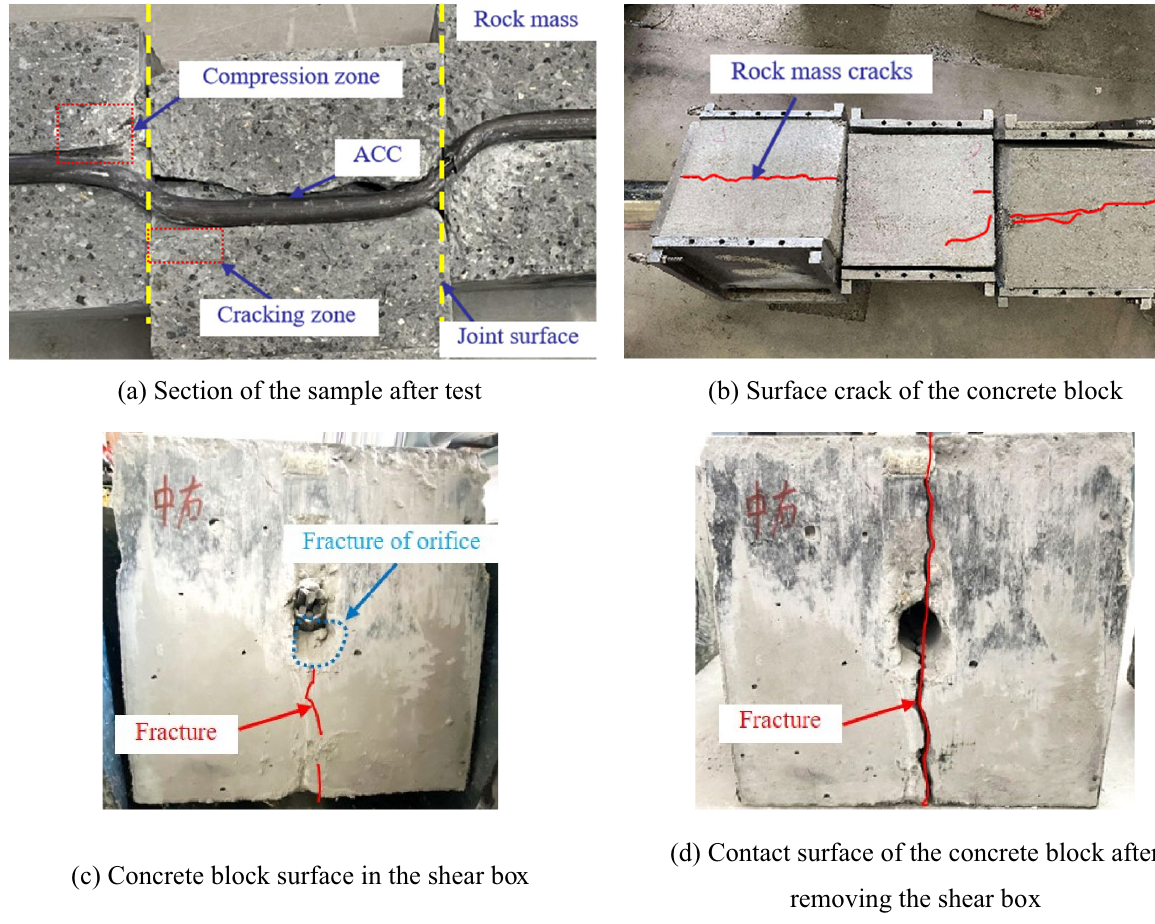
Figure 5. Failure characteristics of the ACC-reinforced jointed rock mass after